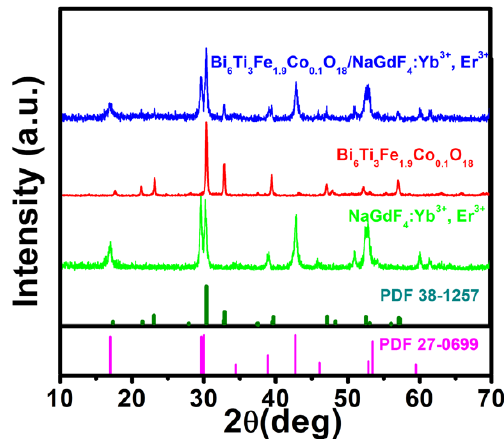
Figure2. The X-ray diffraction (XRD) patterns of the NGF, BFCTO and BFCTO/NGF samples.